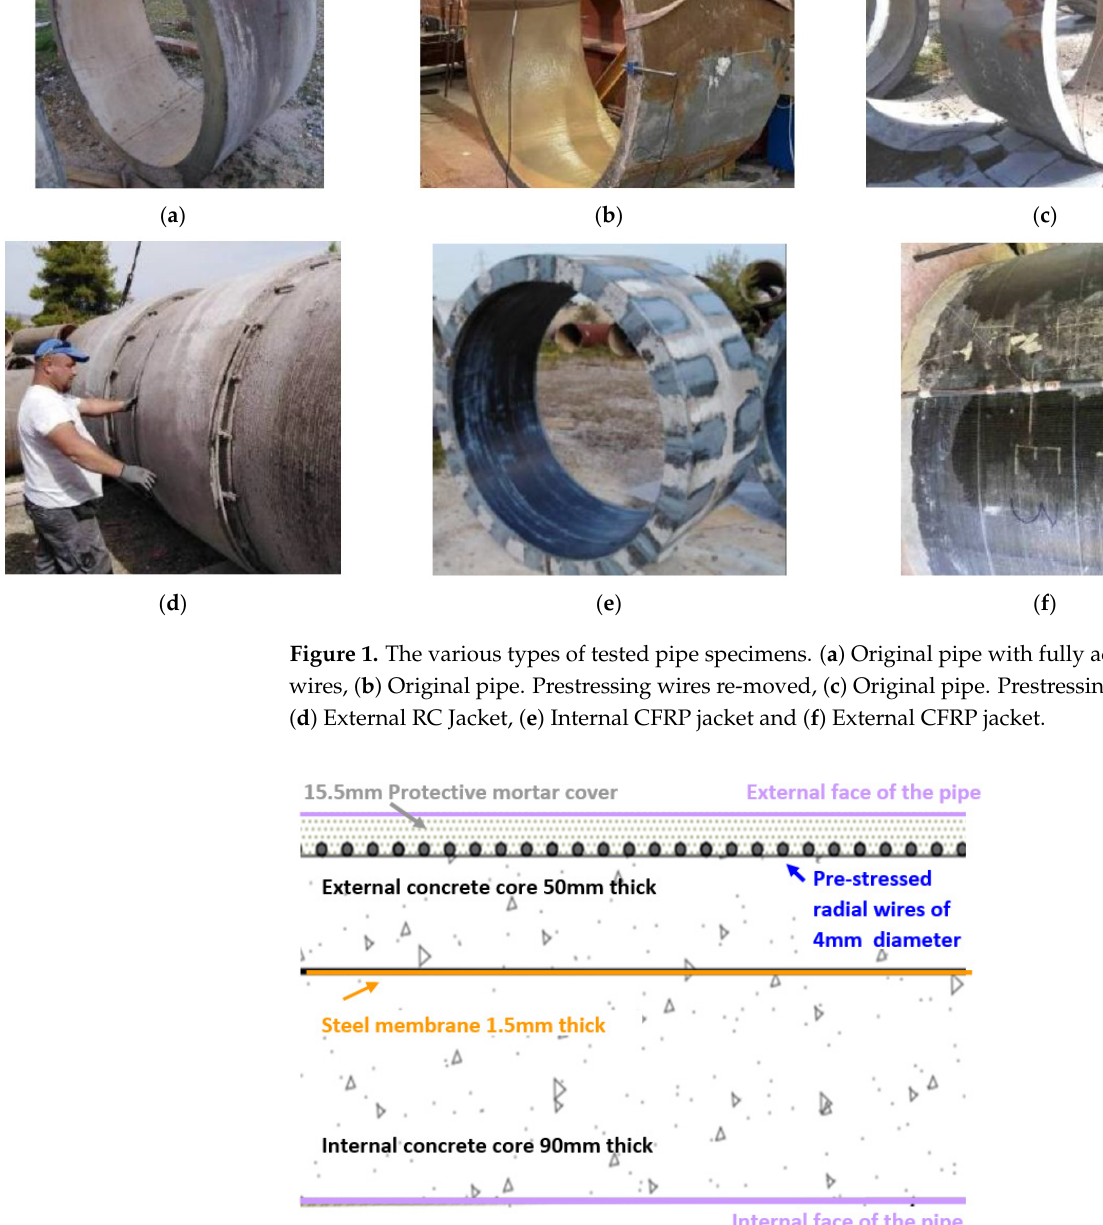
Figure 3. Tensile behaviour of steel membrane coupons taken from tested pipe specimens. Figure 4. Tensile behaviour of prestressing wire specimens. Samples were also taken from the concrete core of the tested PCCP pipes. They formed either cubic specimens (100 mm × 100 mm × 100 mm) for compression tests or prismatic specimens for three ‐ point flexure of 50 mm nominal thickness, 60 mm nominal width and 130 mm nominal length. The obtained results are shown in Figure 5 together with the assumed compression stress–strain concrete constitutive law that was utilized in subsequent numerical simulations. The average compressive cubic stress found from